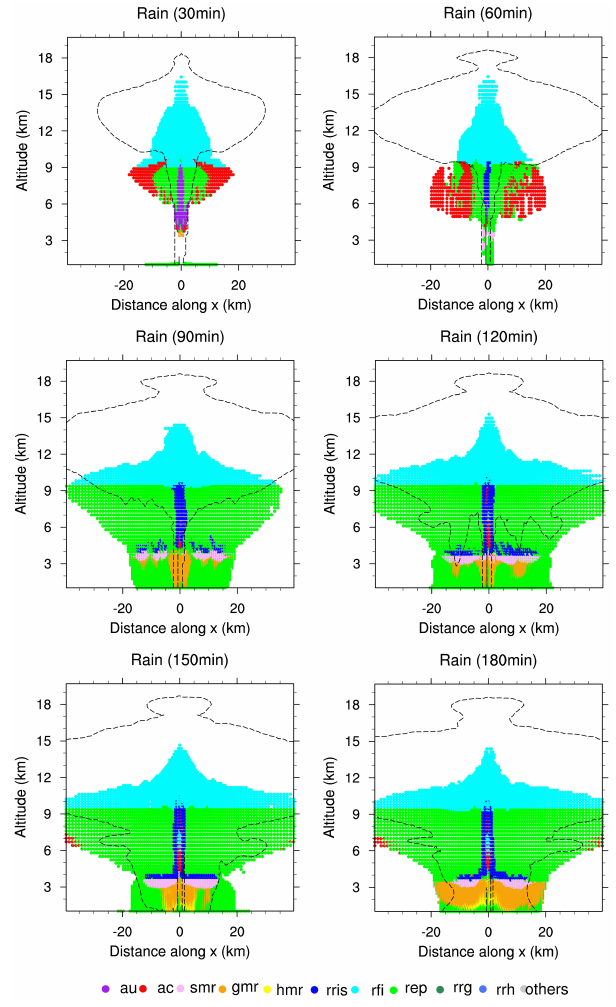
Figure 19. Same as Fig. 17 but for raindrops.